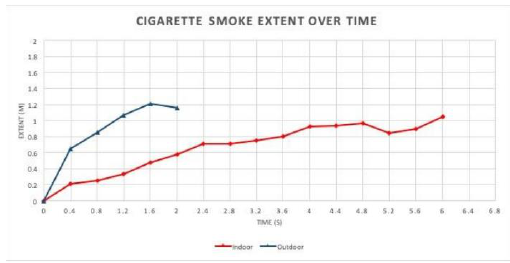
Figure 18. 2D Graph of Cigarette Smoke Extent vs Time in